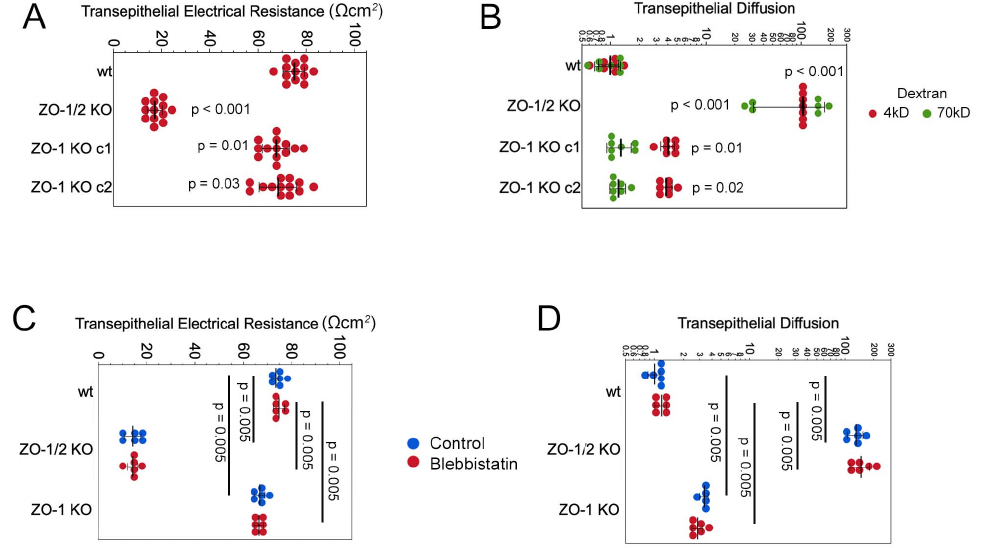
Figure 10. ZO-1-deficiency deregulates monolayer permeability. ( A , B ) TER and paracellular flux assays with fluorescent dextrans of different molecular weights were performed with monolayers of the same age as those analysed by immunofluorescence ( C , D ) TER and paracellular flux assays were repeated as in panels A and B in the presence of the myosin inhibitor blebbistatin. Data points in all panels represent individual filter cultures.